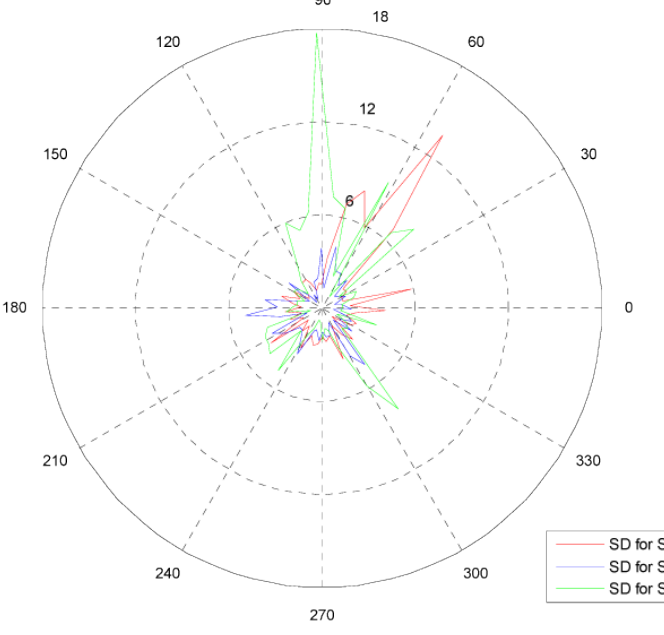
Figure 6. Polar profiles are given for Standard Deviations (SD; units are degrees) for the ACA data for the different meridians of the right eyes of the three subjects involved. Different colours are used to represent the different subjects (see legend). Note that the blue polar profile is mostly close to the polar origin and within the first black, dashed-line, circle and thus for this subject (number 2) the standard deviations for the different meridians were relatively small and less than 4.5 0 . The same is largely true for Subject 3 (green) with the exception of meridians near 48, 62, 91 and 307 0 . The standard deviations for the different meridians for Subject 1 (the red profile) are also mostly near the polar origin with the exception of meridians near 12, 55 and 70 0 . If a few outliers were removed these profiles would probably be found closer to the polar